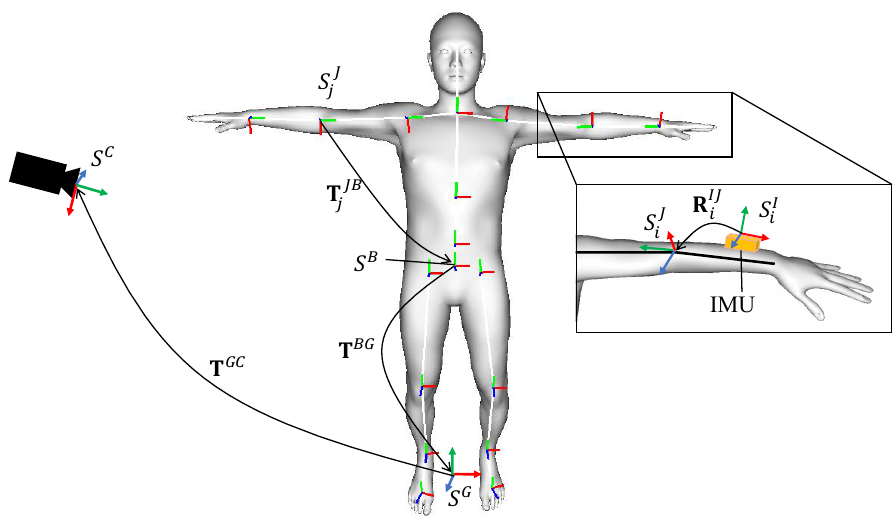
Figure 1. Relations among the local coordinate